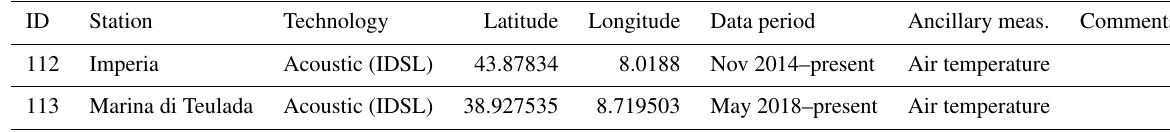
Table A9. IDSL stations operated in Italy by the JRC with ISPRA.